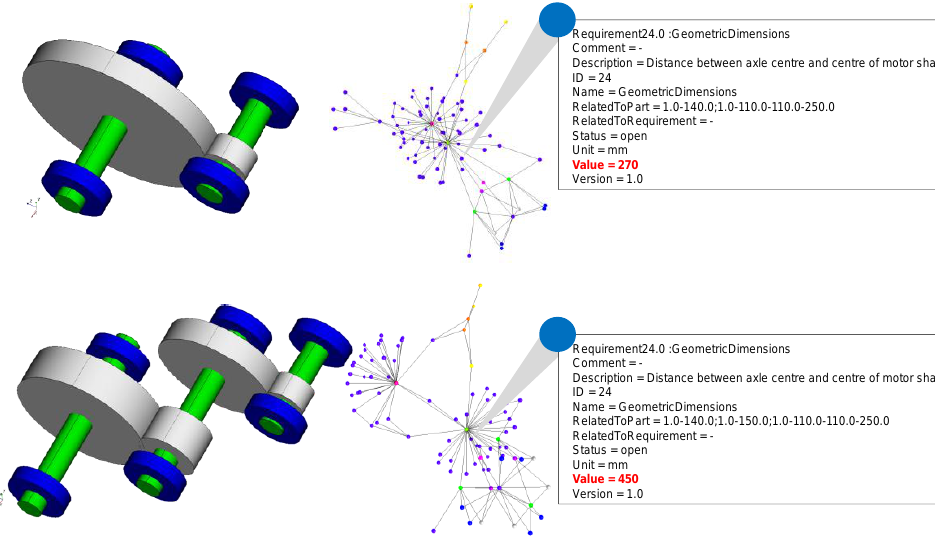
Figure 16. Example for a mapping process of requirements to related product components/parts.